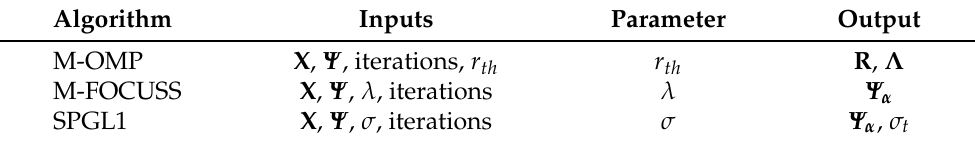
Table 1. Inputs, convergence parameter and output of the analyzed reconstruction